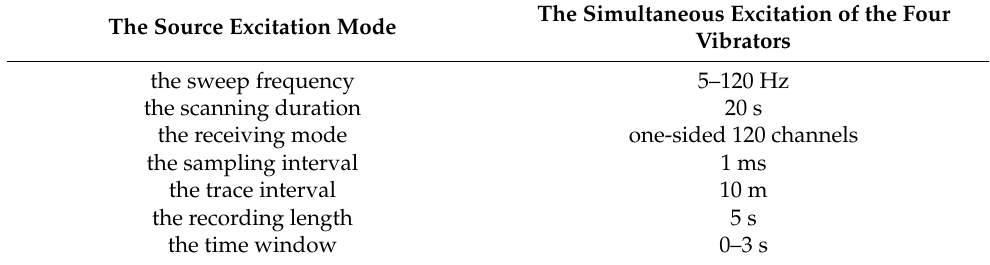
Table 1. Field seismic data